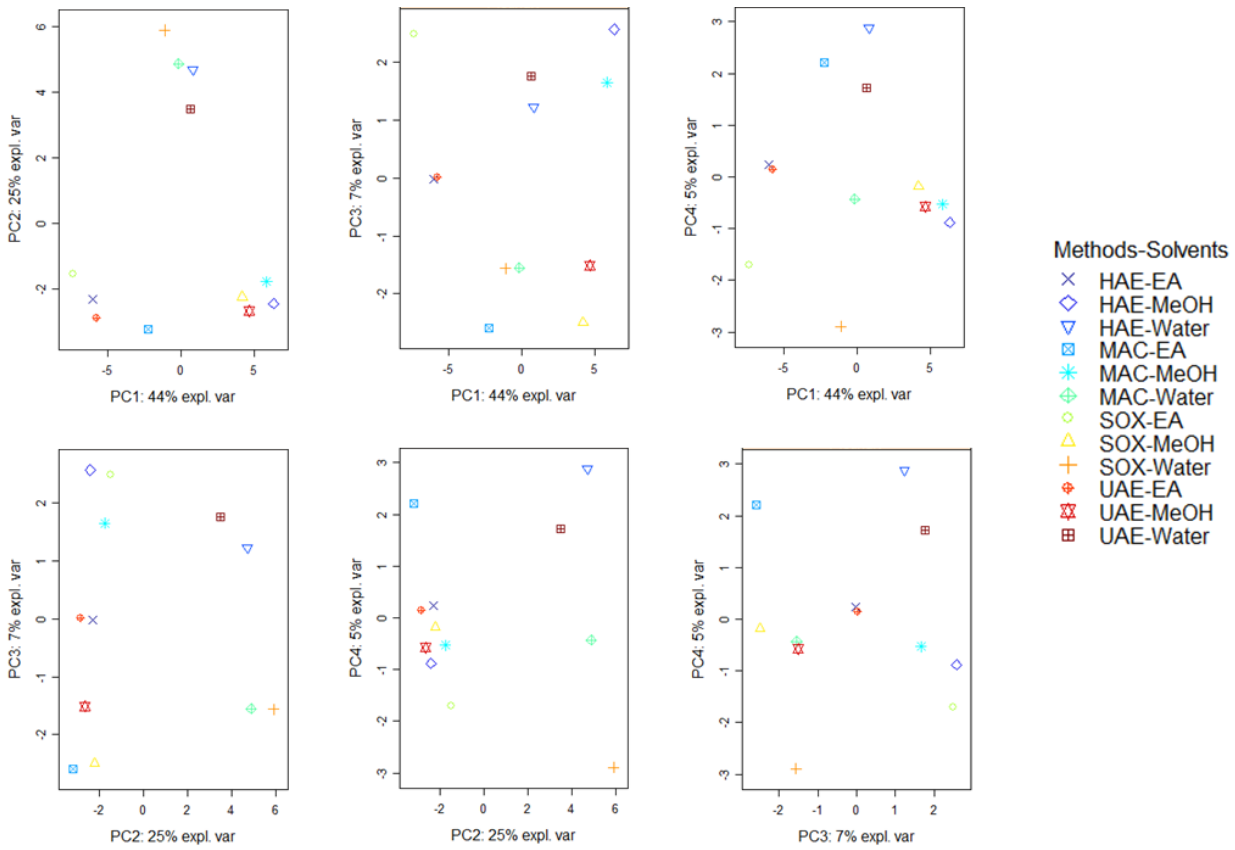
Figure 1. Score plots of Principal component analysis on the secondary metabolites of Alcea fascicu- liflora